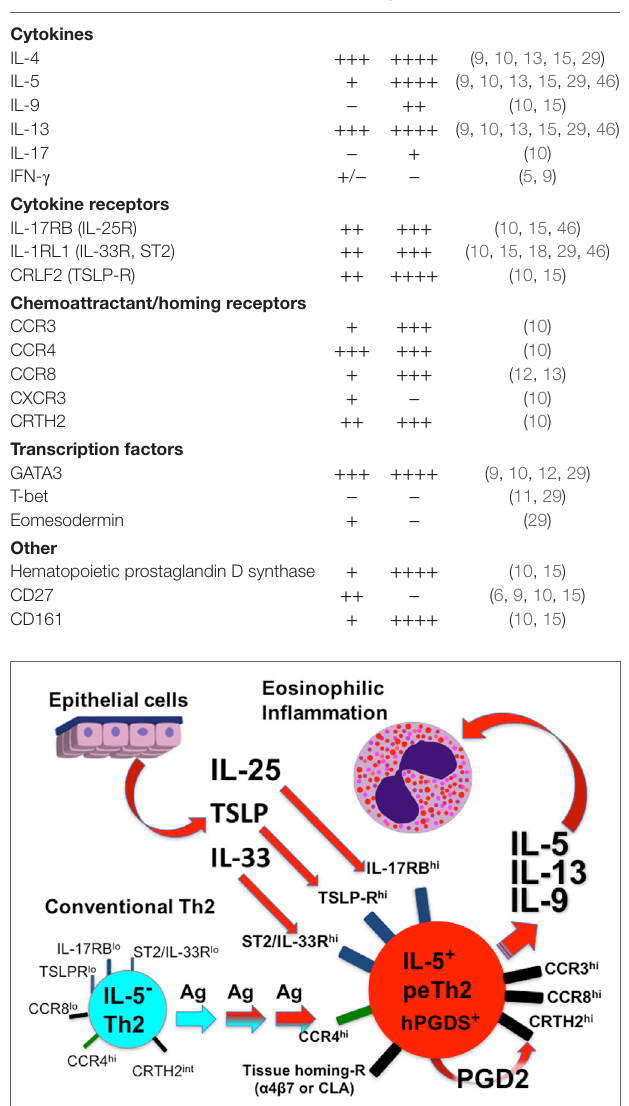
FiGURe 1 | Development of peTh2 enhances Th2 function thereby driving chronic allergic